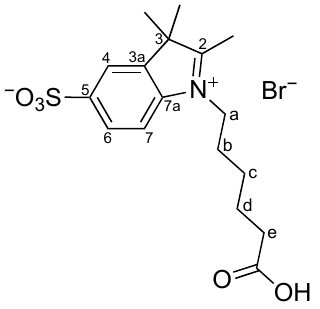
Figure 3. Structure of indolium salt 3 .